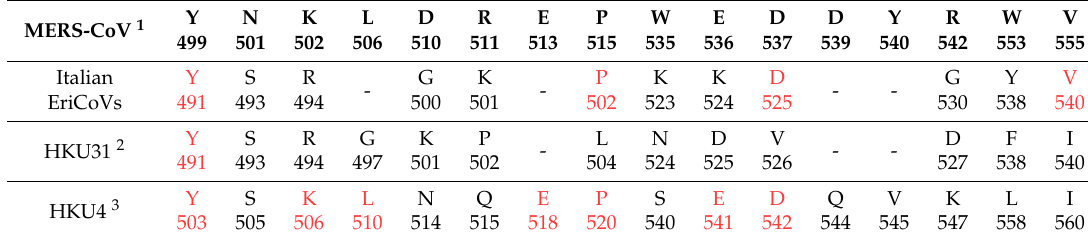
Table 3. Multiple sequence alignment showing variations in key amino acid binding residues of the Spike protein. Conserved residues are highlighted in